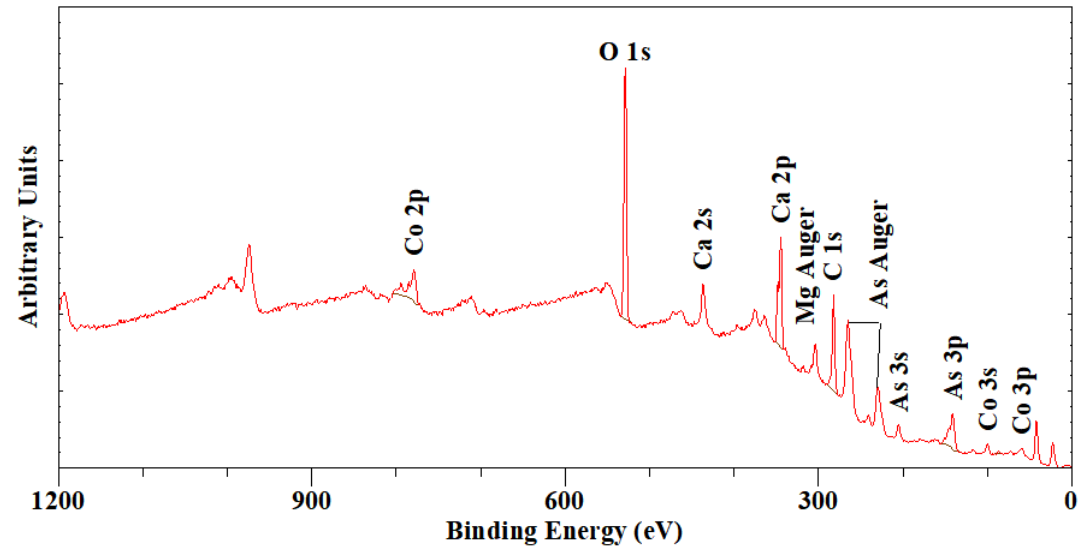
Figure 3. XPS survey scan (Al K α , 225 W, 160 eV pass energy) of roselite. Table 1. Chemical compositions based on XPS survey scan analysis on total cation sum = 5. Element Atom%2 Atoms per Formula Unit